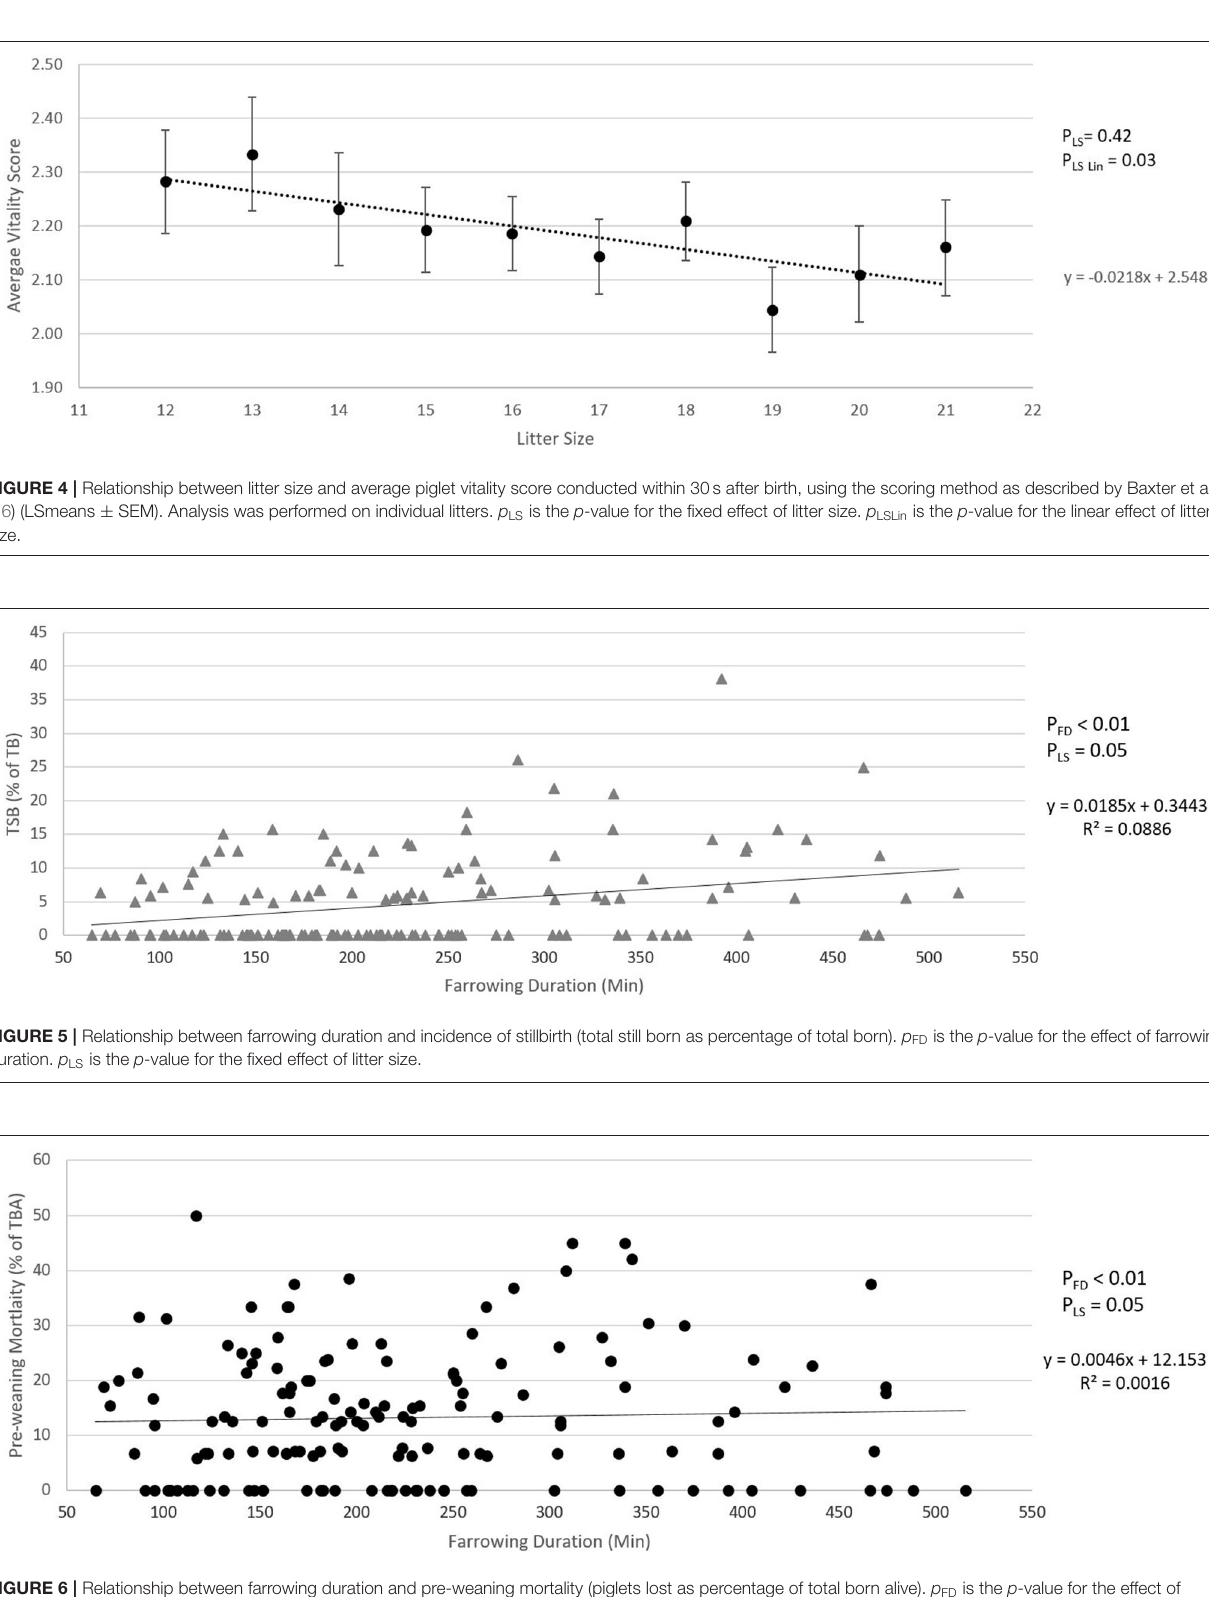
FIGURE 6 | Relationship between farrowing duration and pre-weaning mortality (piglets lost as percentage of total born alive). p FD is the p -value for the effect of farrowing duration. p LS is the p -value for the effect of litter